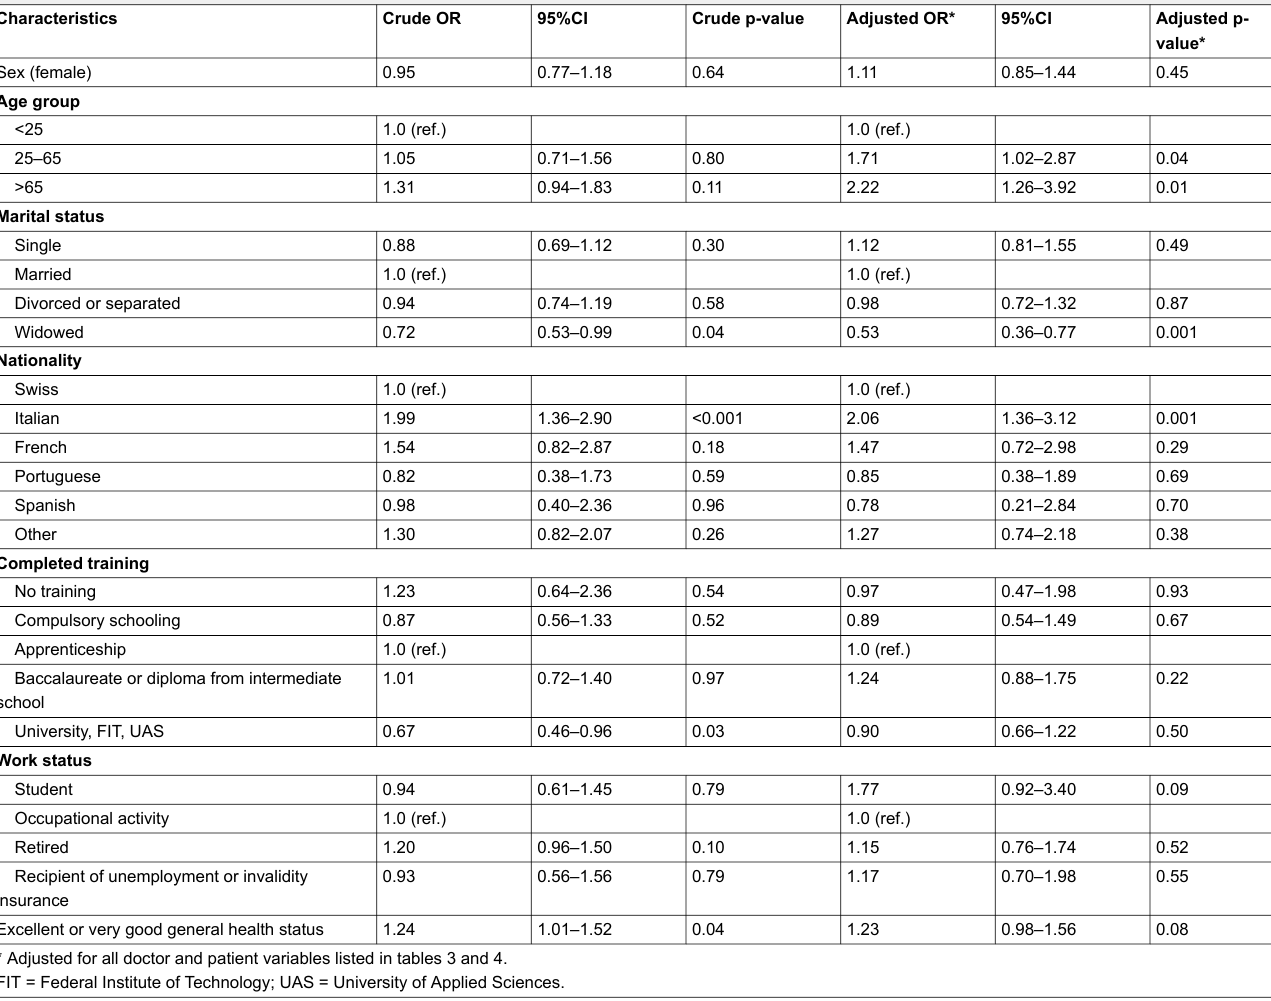
Table 3: Patient views on whether GPs should wear white coats according to patient characteristics (n = 1,327). Characteristics